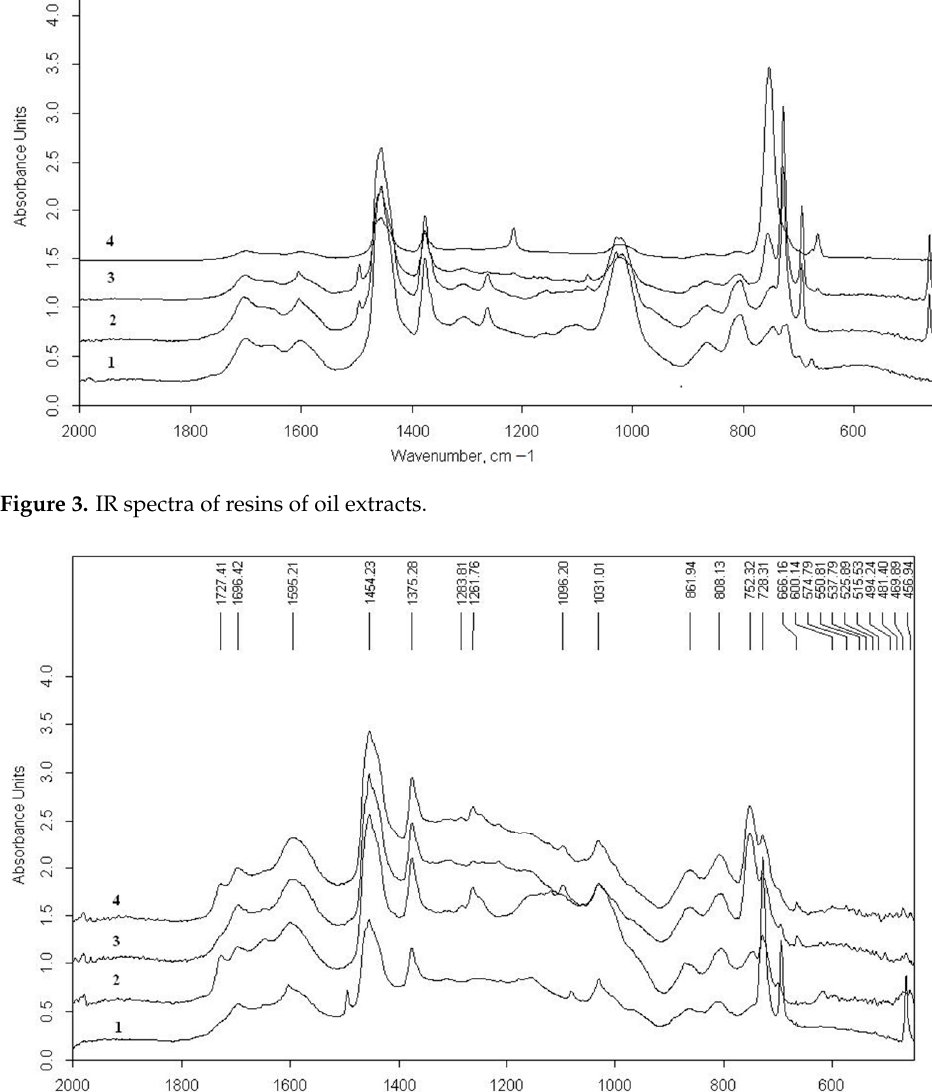
Figure 4. IR spectra of asphaltenes of oil extracts. Table 5. Results of IR spectral analysis of resins.